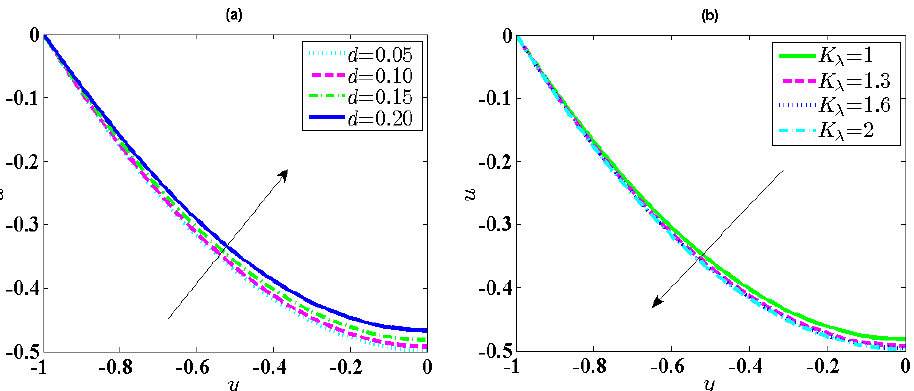
Figure 2. Distribution of the velocity when λ = 0.25, α = 1, u r = 0.1, R = 1. ( a ) Influence of d (0.05, 0.10, 0.15, 0.20) when K λ = 1; ( b ) Influence of K λ (1, 1.3, 1.6, 2) when d = 0.15.